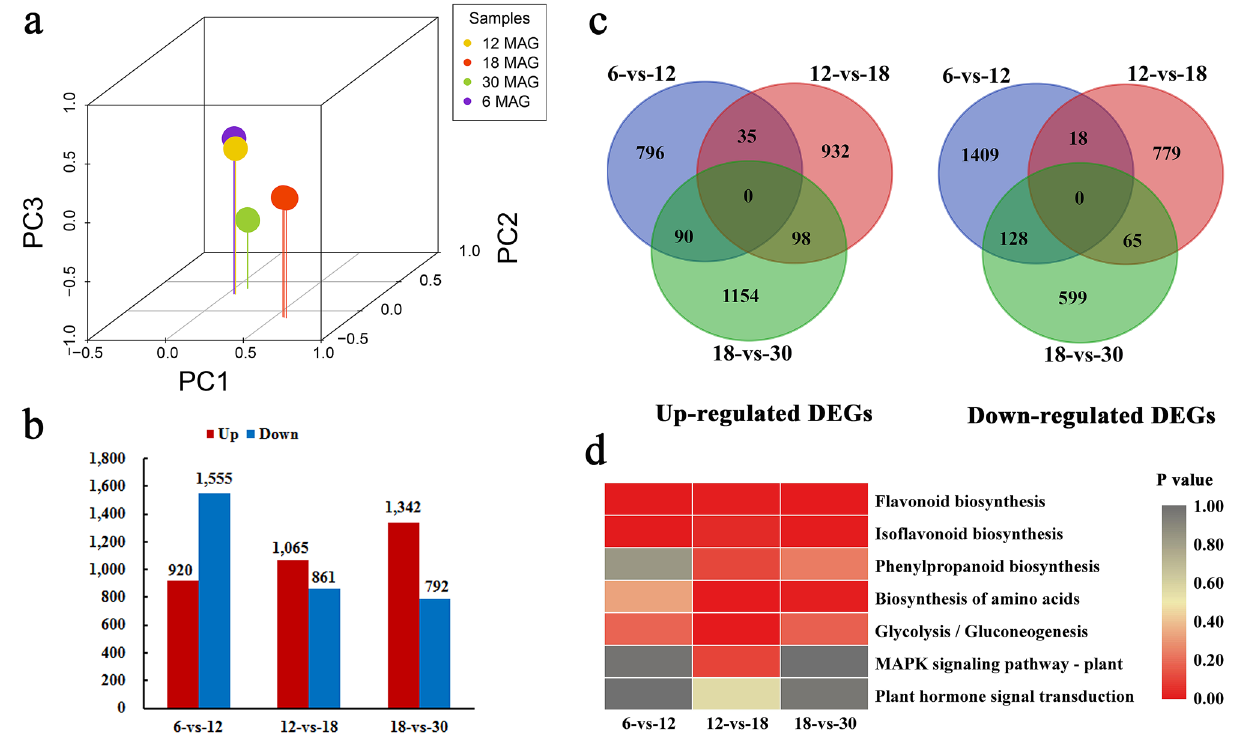
Figure 3. Global gene expression profiling of C. speciosa roots at different developmental ages. ( a ) PCA analysis of the RNA-Seq data. ( b ) Numbers of identified differentially expressed genes (DEGs) in the sequential pairwise comparisons. ( c ) Venn diagrams of DEGs among the three comparisons. ( d ) Significantly enriched KEGG pathways of DEGs. The numbers (6, 12, 18, 30) represent the four different developmental